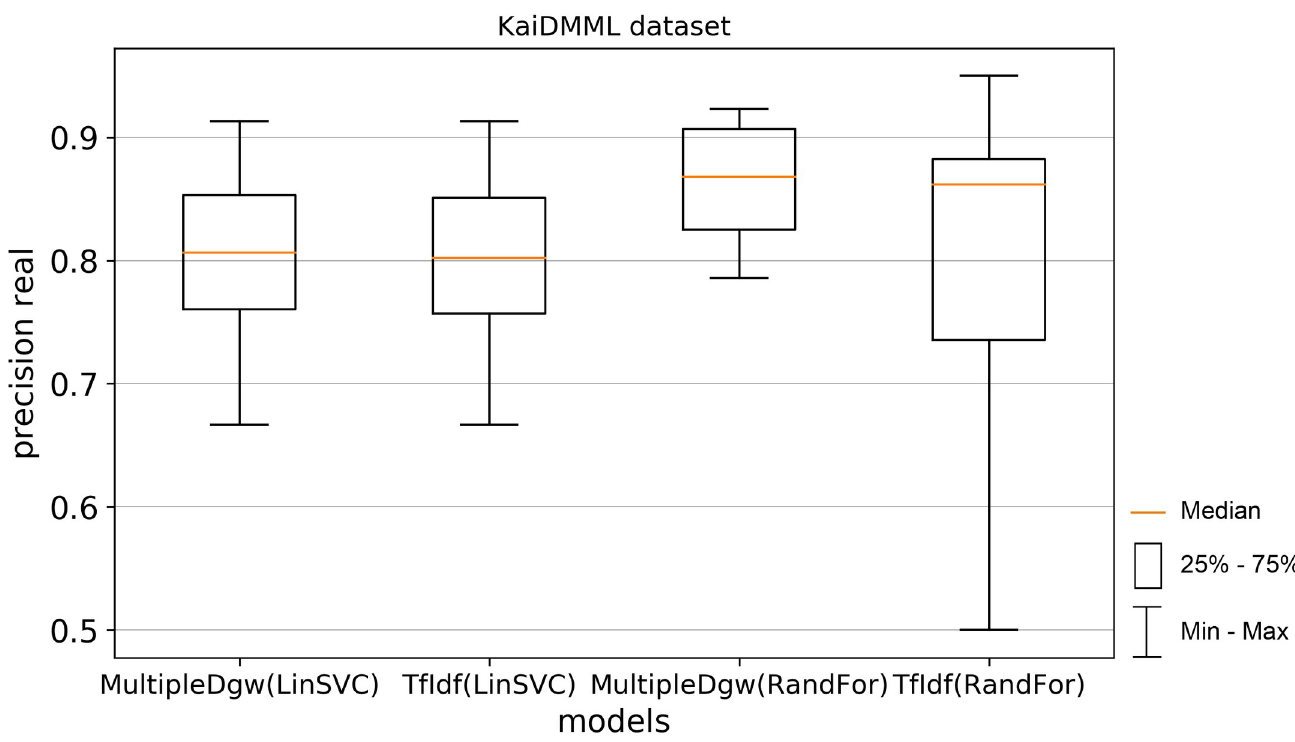
Fig 9. Boxplot for the model performance measurement—precision_real for dataset KaiDMML.